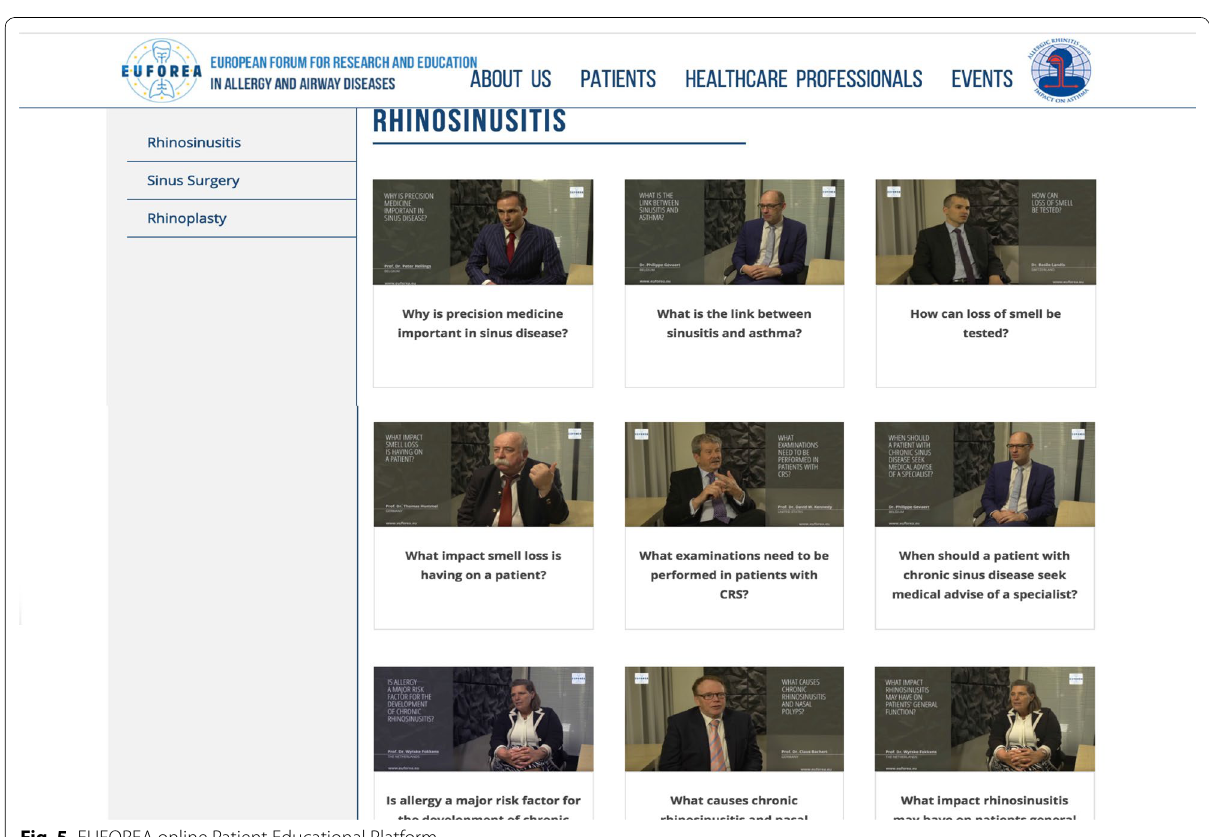
Fig. 5 EUFOREA online Patient Educational